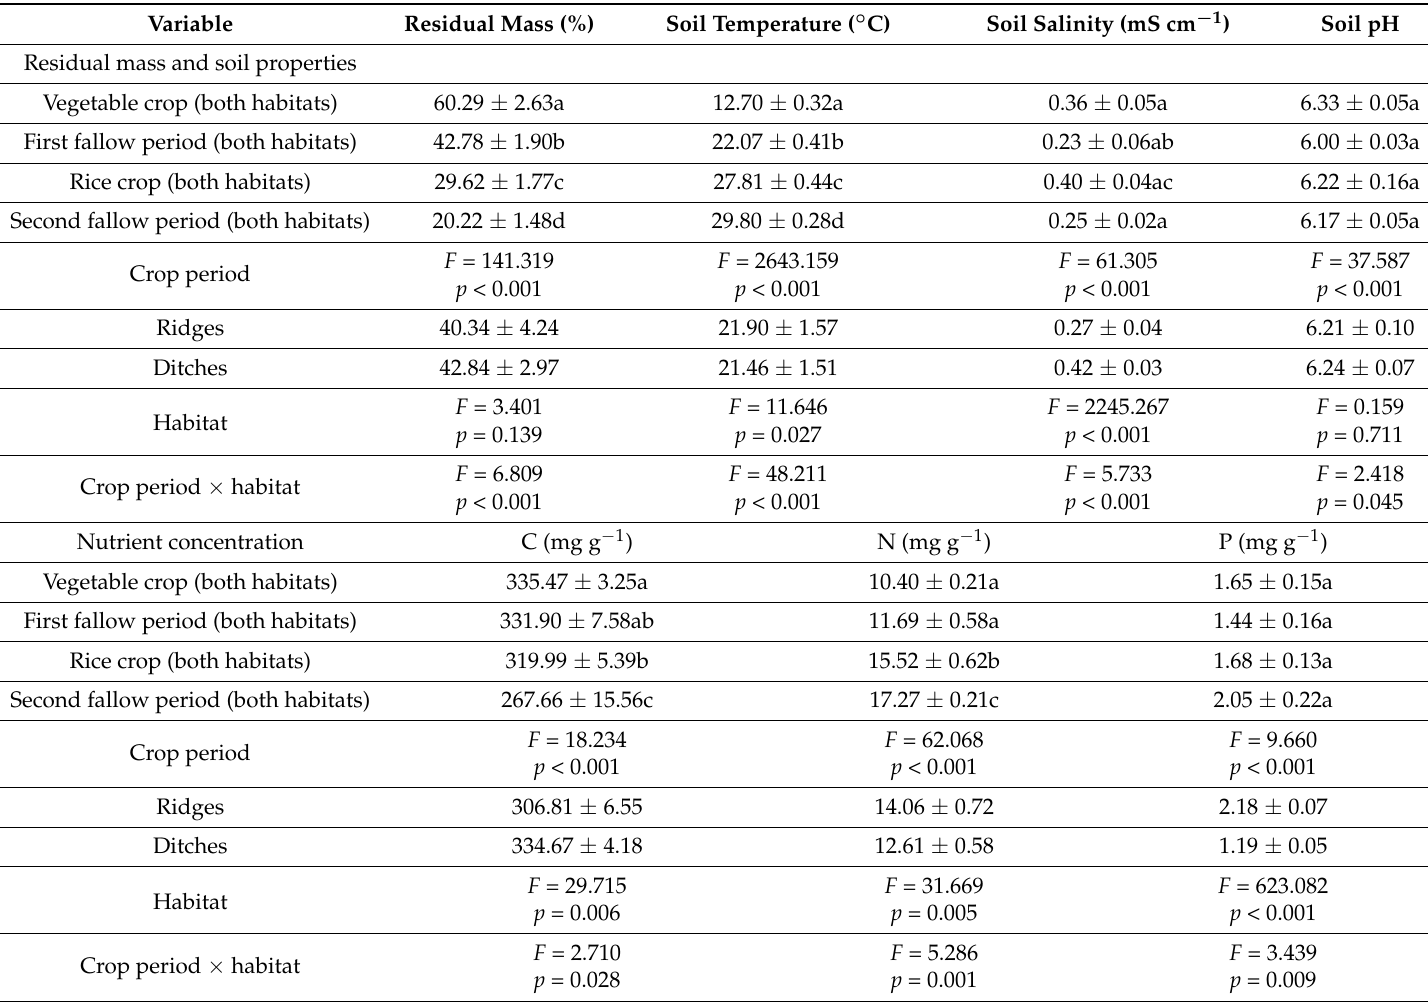
Table A2. Residual mass, nutrient characteristics of the straw, and physical soil traits (mean ± SE) in each crop